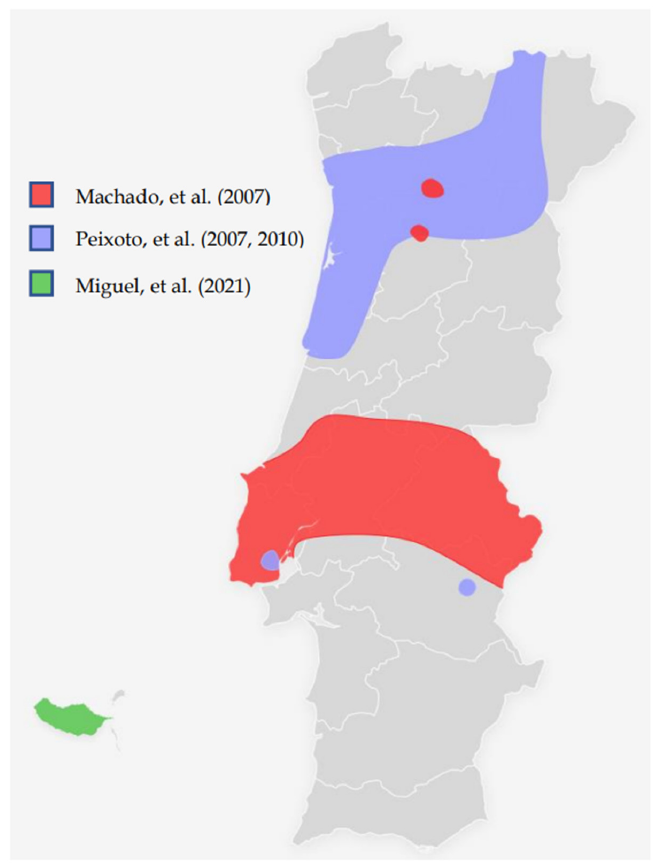
Figure 1. Map of Portugal showing the known geographical origin of the families with the c.156_157insAlu BRCA2 germline mutations according to the different studies [27,28,31]. A small study conducted in IPO de Coimbra pointed to the clinical characteristics of 78 patients from central Portugal with the c.156_157insAlu BRCA2 mutation followed in this oncology centre. Two patients (7.4%) had OC, four patients (14.8%) had bilateral BC at diagnosis, and nine patients (33.3%) had second cancers some years later (breast, pros- tate, colorectal and skin). Related to BC, “luminal B-like” was the most frequent subtype (55.2%). The prevalence of “Luminal A-like”, “Luminal B-HER2+”, and TNBC were 24.1%, 6.9% and 13.8%, respectively. None of the patients was a stage IV at diagnosis, but 30% had metastatic progression during the surveillance time [32]. Other possible founder mutation genes in Portugal are being discussed. In addition to c.156_157insAlu in BRCA2 , Peixoto, et al. also reported two other mutations in the BRCA1 gene (c.2037delinsCC and c.3331_3334del). Those three represent about 50% of all pathogenic mutations in Portuguese HBOC families. A preliminary haplotype study of c.2037delinsCC mutation revealed that three families with this mutation share a common ancestor [30]. The c.3331_3334del mutation was reported in different populations, includ- ing Spain, Africa, Canada, Brazil and Colombia. Tuazon, et al. suggested that this muta- tion originated in the Iberia peninsula and was later introduced in South America. More- over, both mutations reported in BRCA1 shared a common haplotype, indicating the pos- sibility of being founder mutations in the Portuguese population [33].